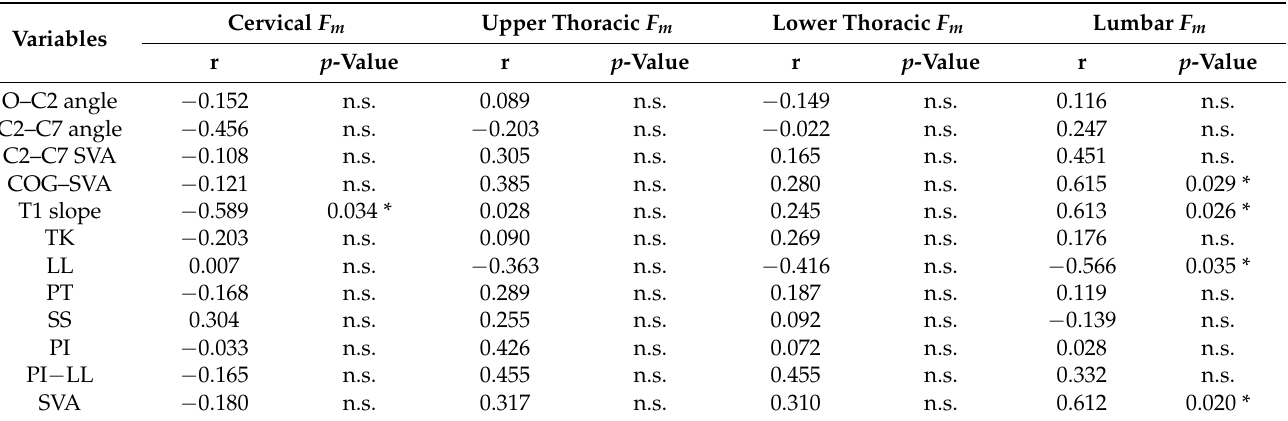
Table 3 showed the Spearman’s correlation coefficients between the mean 𝐹 (cid:3040) at each region and spinopelvic sagittal alignment parameter. Table 3. Spearman’s correlation coefficients between the mean disc compression force at each part and spinopelvic sagittal alignment parameter in all patients.